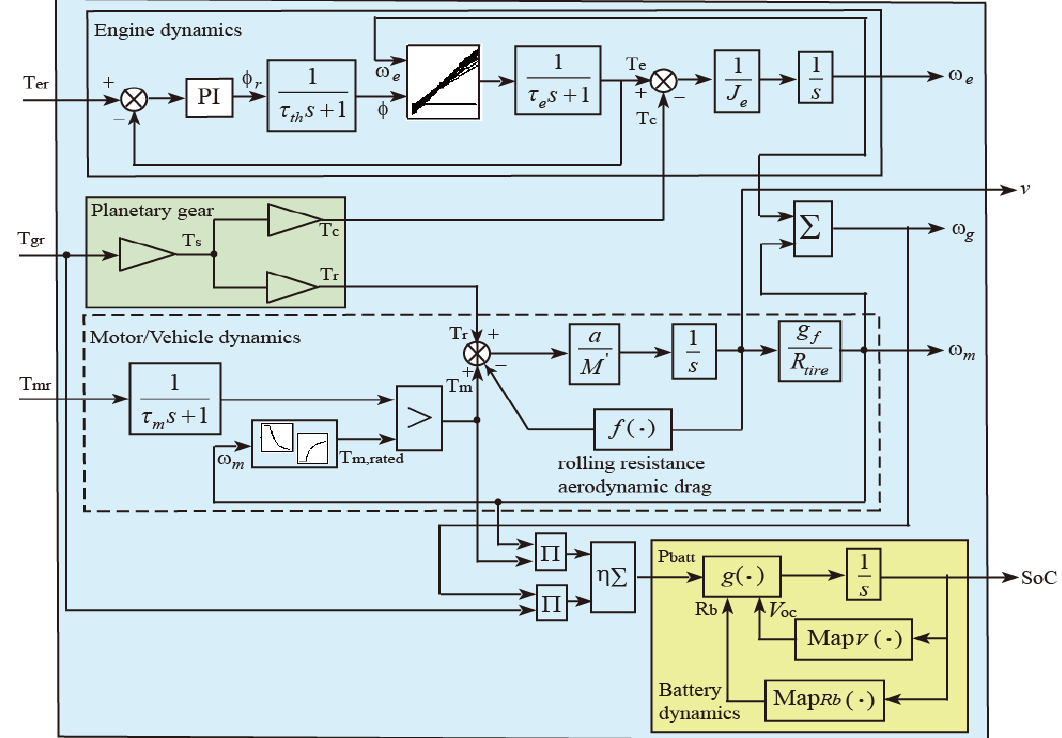
Figure 12. Schematic diagram of model resembling real powertrain in